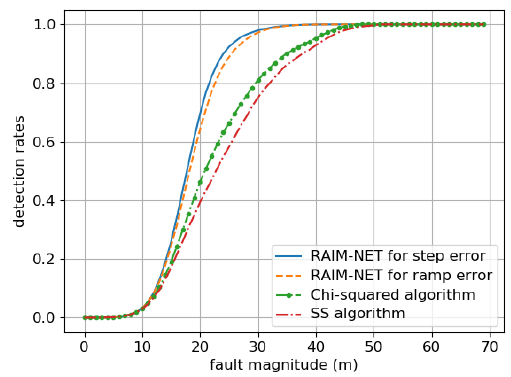
Figure 6. Fault detection rates of different methods.